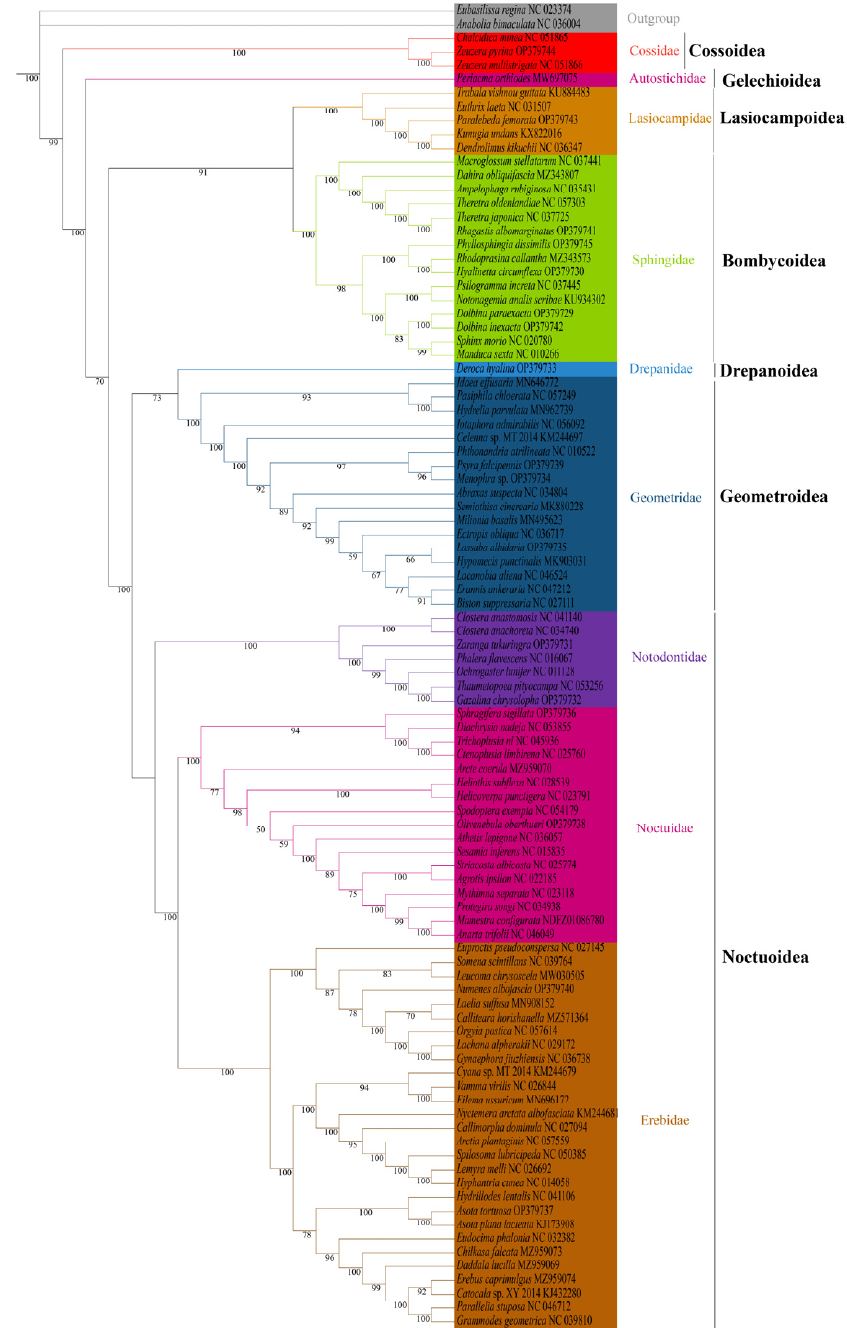
Figure 6. Phylogenetic tree inferred from DNA sequences of 13 PCGs using maximum likelihood (ML) analysis. Numbers on branches are bootstrap percentages.